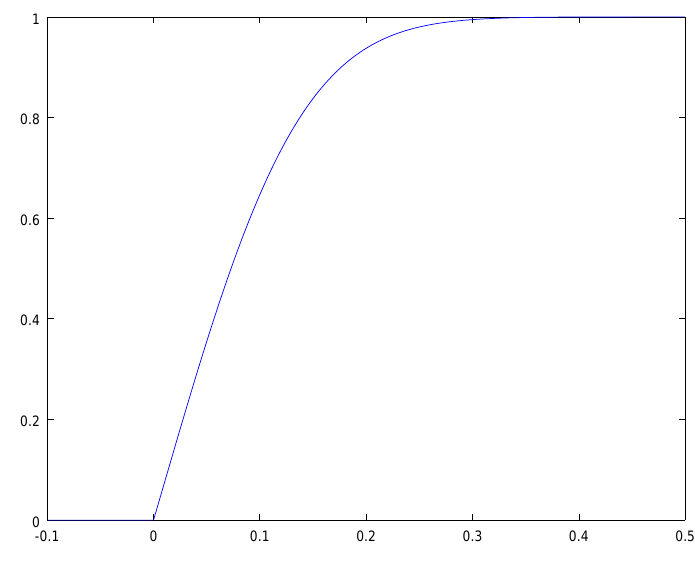
Figure 2. Example 1 (i). Function P ( W ≤ t | A ) is marked on the vertical axis, and time is marked on the horizontal axis.